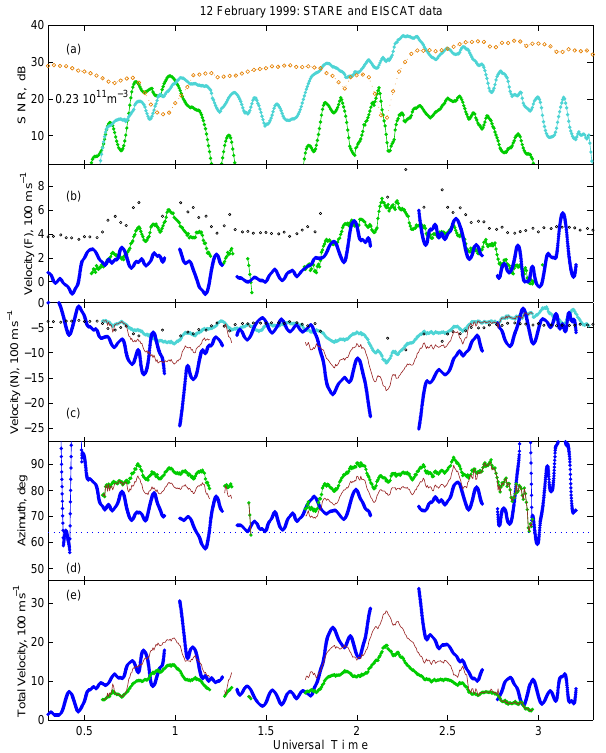
Fig. 2. The STARE (Finland radar beam 3 and the Norway radar Figure 2: Uspensky et al. beam 4) and EISCAT parameters: (a) SNR, green line for Fin- land and light blue line for Norway; orange open circles are mean electron densities between 103 and 123km (in logarithmic scale); (b) Finland line-of-sight velocity, green line, and matched EISCAT V E × B velocity component, dark blue line; open black circles are the ion-acoustic speed at 111km according to EISCAT; (c) the same as in (b) but for the STARE-Norway beam 4, light blue line is the Norway l-o-s flow velocity; red line is the STARE-predicted elec- tron velocity component, according to the IAA method; (d) the standard STARE merged flow velocity azimuth, green line, and the EISCAT V E × B electron flow azimuth, blue line, red line is the IAA STARE electron velocity azimuth, (e) the total EISCAT and STARE flow velocity, blue and green lines, together with the IAA-predicted electron flow velocity, red